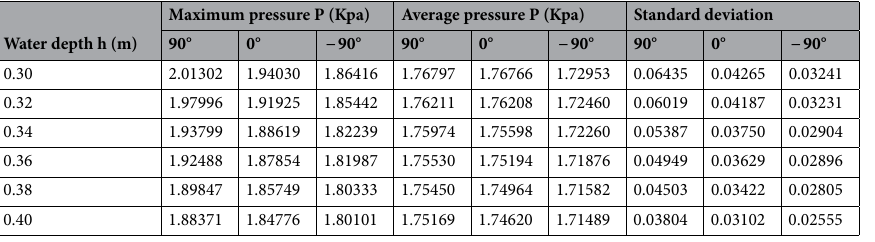
Table 2. Pressure data at 90°, 0° and − 90°measuring points of underwater pipelines in different water depths.